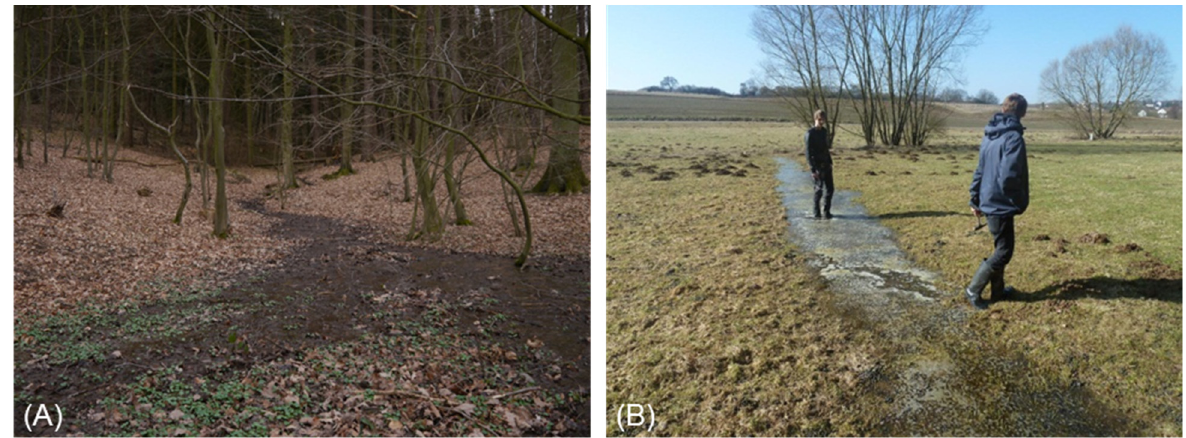
Figure 10. Photos showing the ephemeral tributary ( A ) originating from the forest and ( B ) draining into the stream near to piezometer